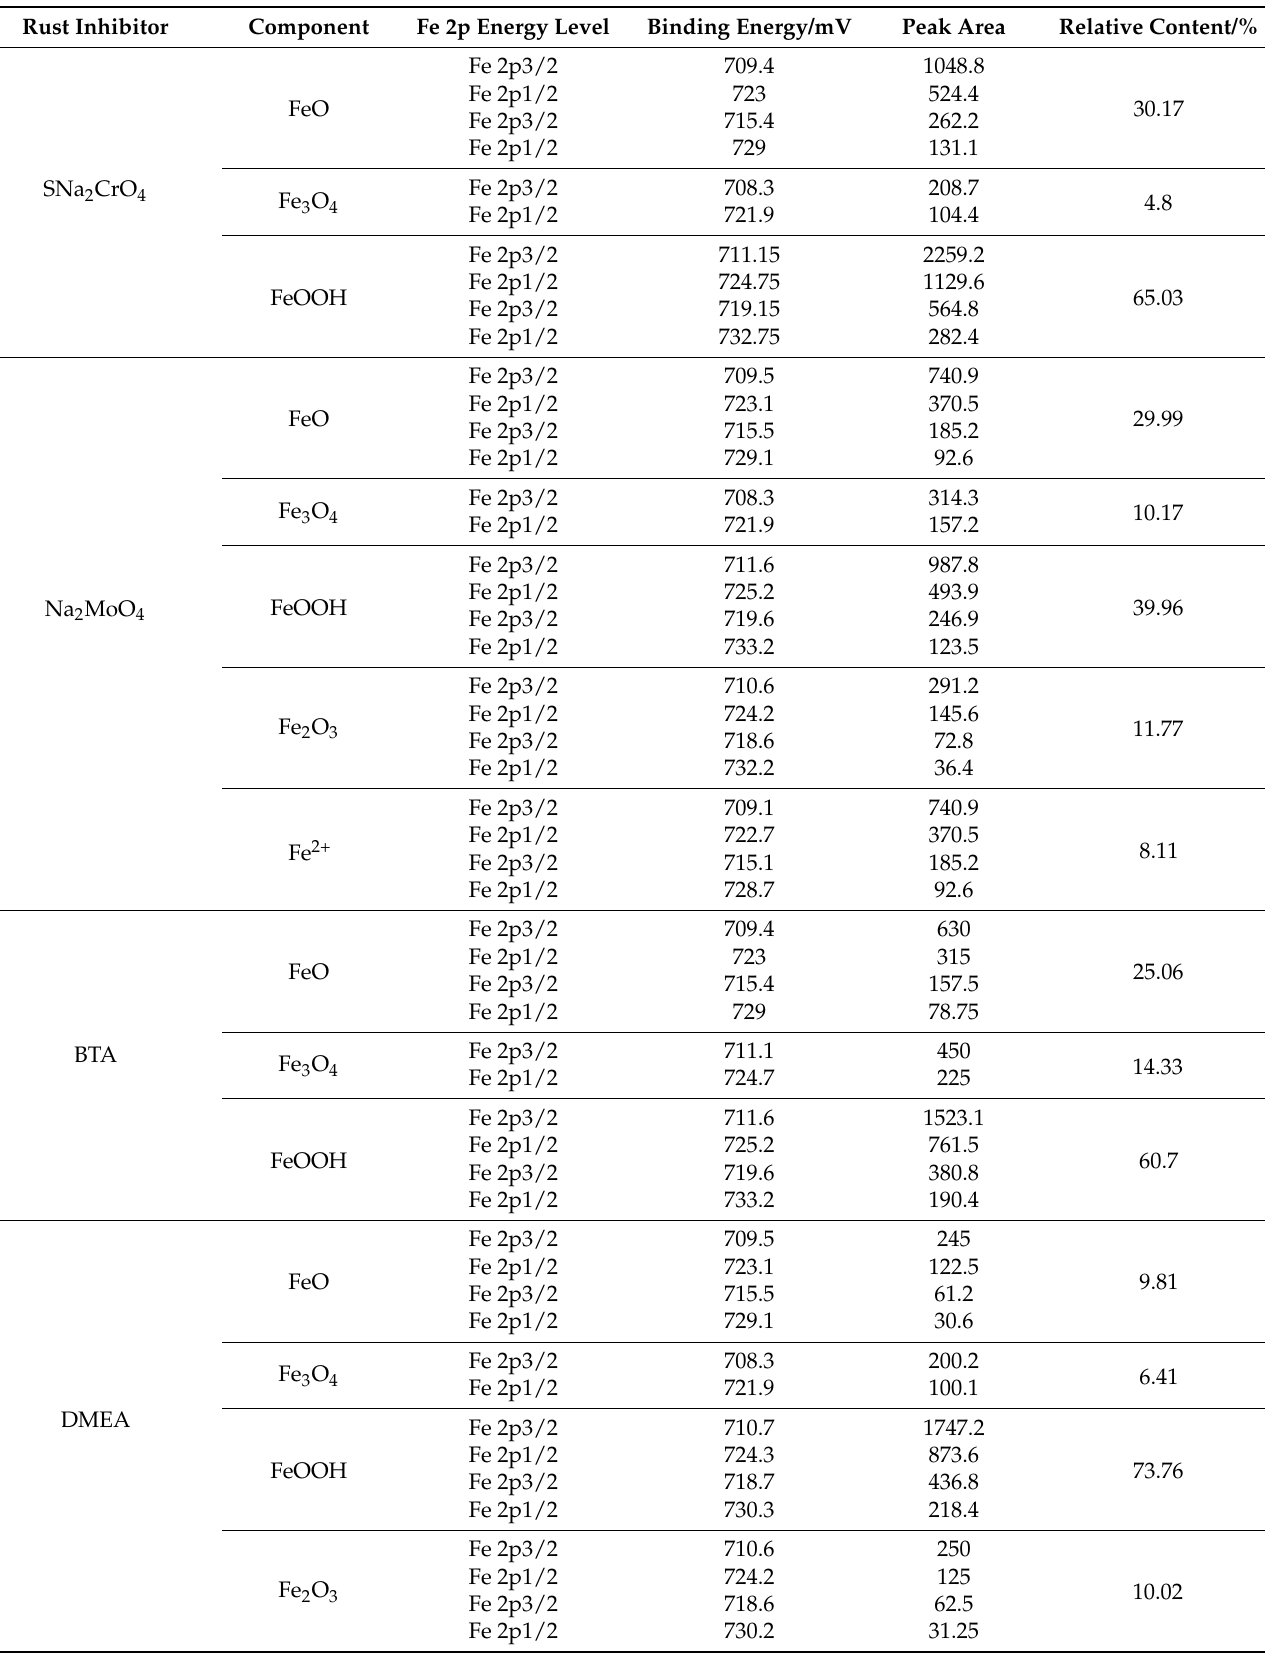
Table 4. Fitting data of the Fe element in different